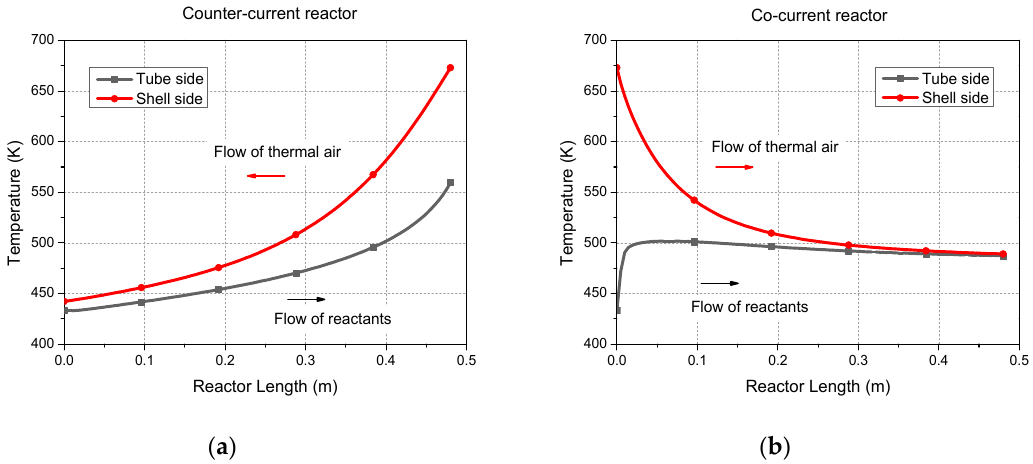
Figure 4. Temperature profiles of both tube side and shell side in a ( a ) counter-current reactor, and a ( b ) co-current reactor along the length of the reactor.